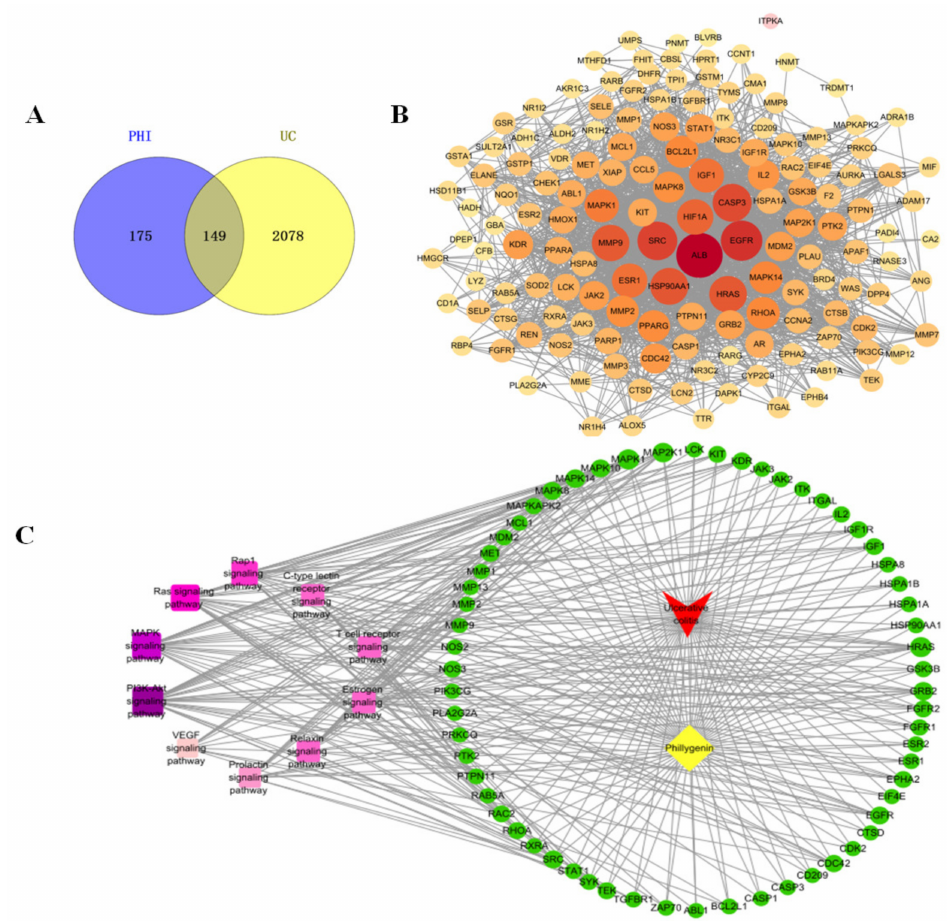
Figure 7. Network pharmacology analysis. ( A ) Venn diagram of potential targets of PHI against UC. ( B ) PPI network of 149 potential targets. ( C ) Disease-component-target-pathway network. PHI was marked in yellow, UC in red, targets in green, and signaling pathways in